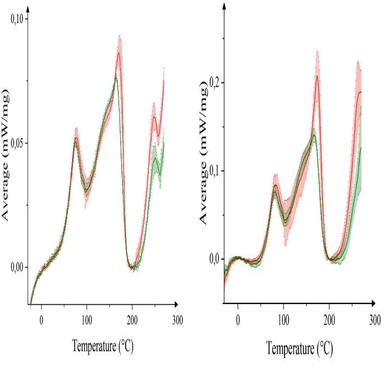
Average curve and standard deviation of 10 DSC measurements with heating rate of 15 ◦C/min (a) and 30 ◦C/min (b), respectively: (red) DSC without HTA and (green) DSC with HTA.